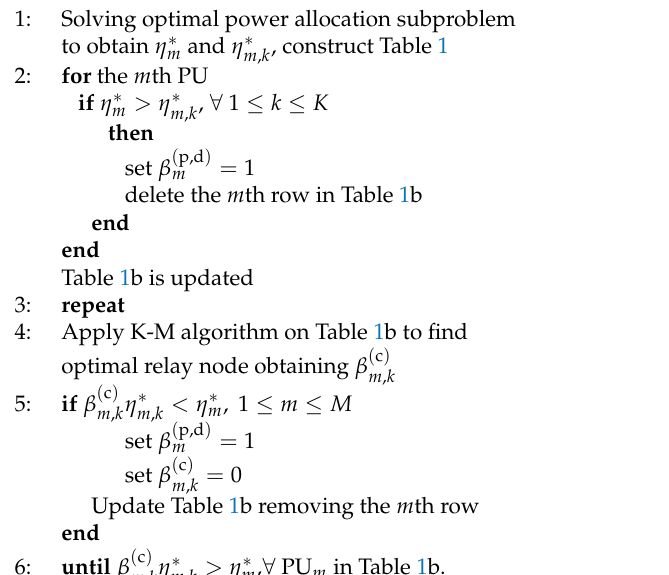
Algorithm 2. Transmission Mode and Relay Selection Optimization